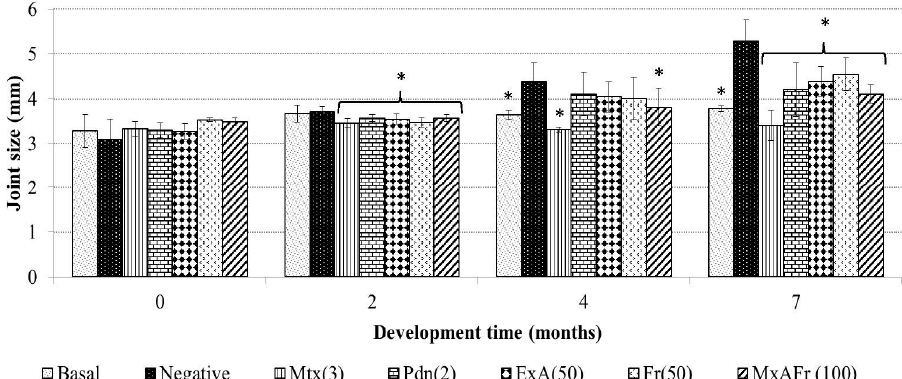
Figure 1. Effect of the oral administration of different treatments on joint size of Balb/c female mice with SLE induced with pristane. Methotrexate, 3 mg/Kg (Mtx); prednisone, 2.5 mg/Kg (Pdn); Agave acetone extract, 50 mg/Kg (ExA); fructans, 50 mg/Kg (Fr); mixture of acetone extract and fructans, 100 mg/Kg (MxAFr) (each column represents an average ± S.E., n = 12, ANOVA, Bonferroni post-test, * p < 0.05 compared to the negative control group).